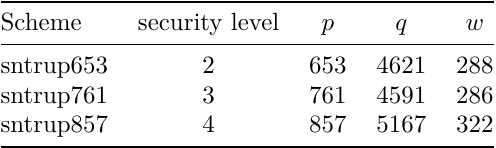
Table 1: Parameter sets of Streamlined NTRU